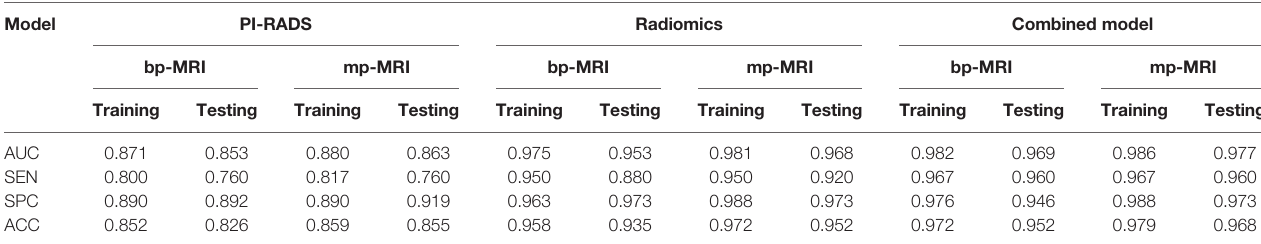
TABLE 4 | ROC results of the PI-RADS, radiomics, and PI-RADS-radiomics combined models for predicting csPCa. Model PI-RADS Radiomics Combined